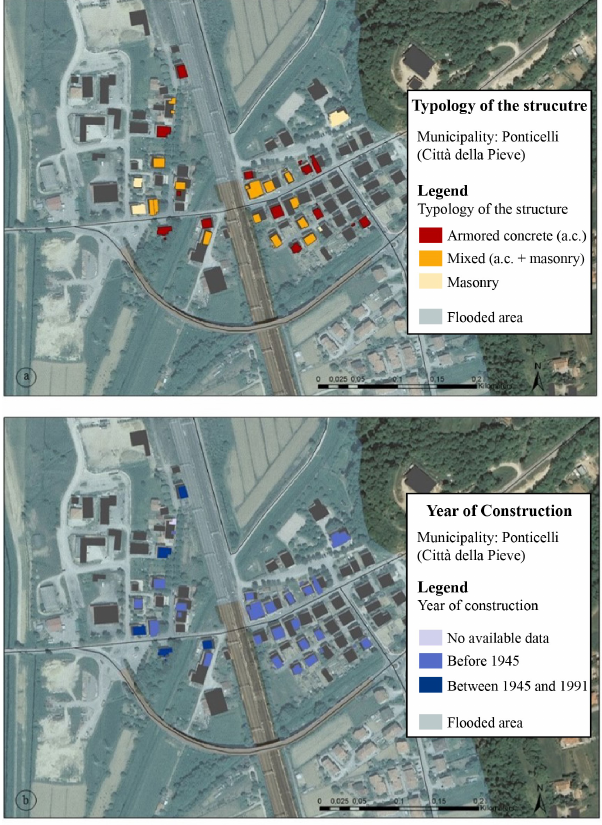
Figure 4. Features of flooded buildings in Città della Pieve: (a) ty- pology of the structure, (b) year of